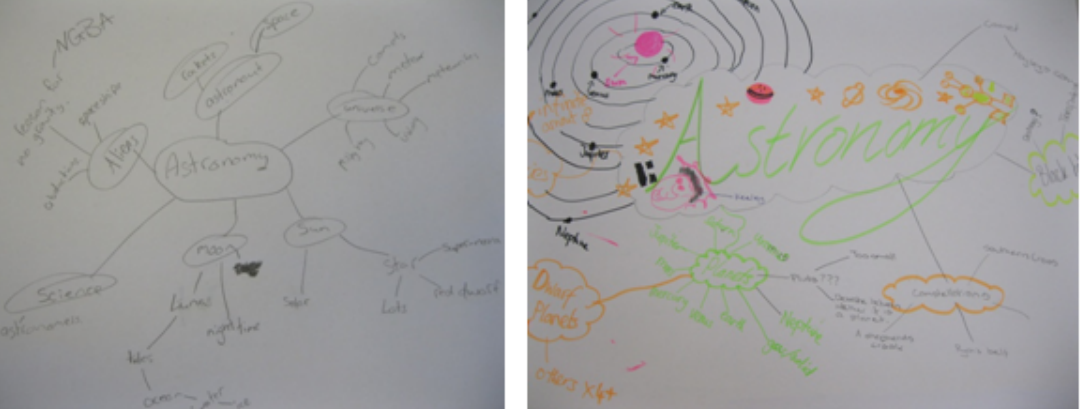
Figure 1. Students’ Mind